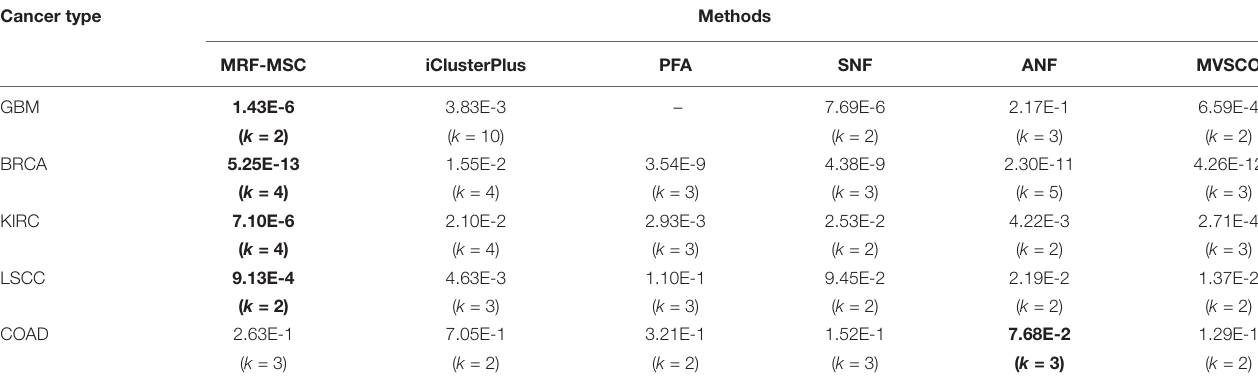
TABLE 4 | Comparison of P -values of survival analysis between MRF-MSC and other algorithms on five cancer multi-omics data sets in Rappoport and Shamir (2018). Cancer